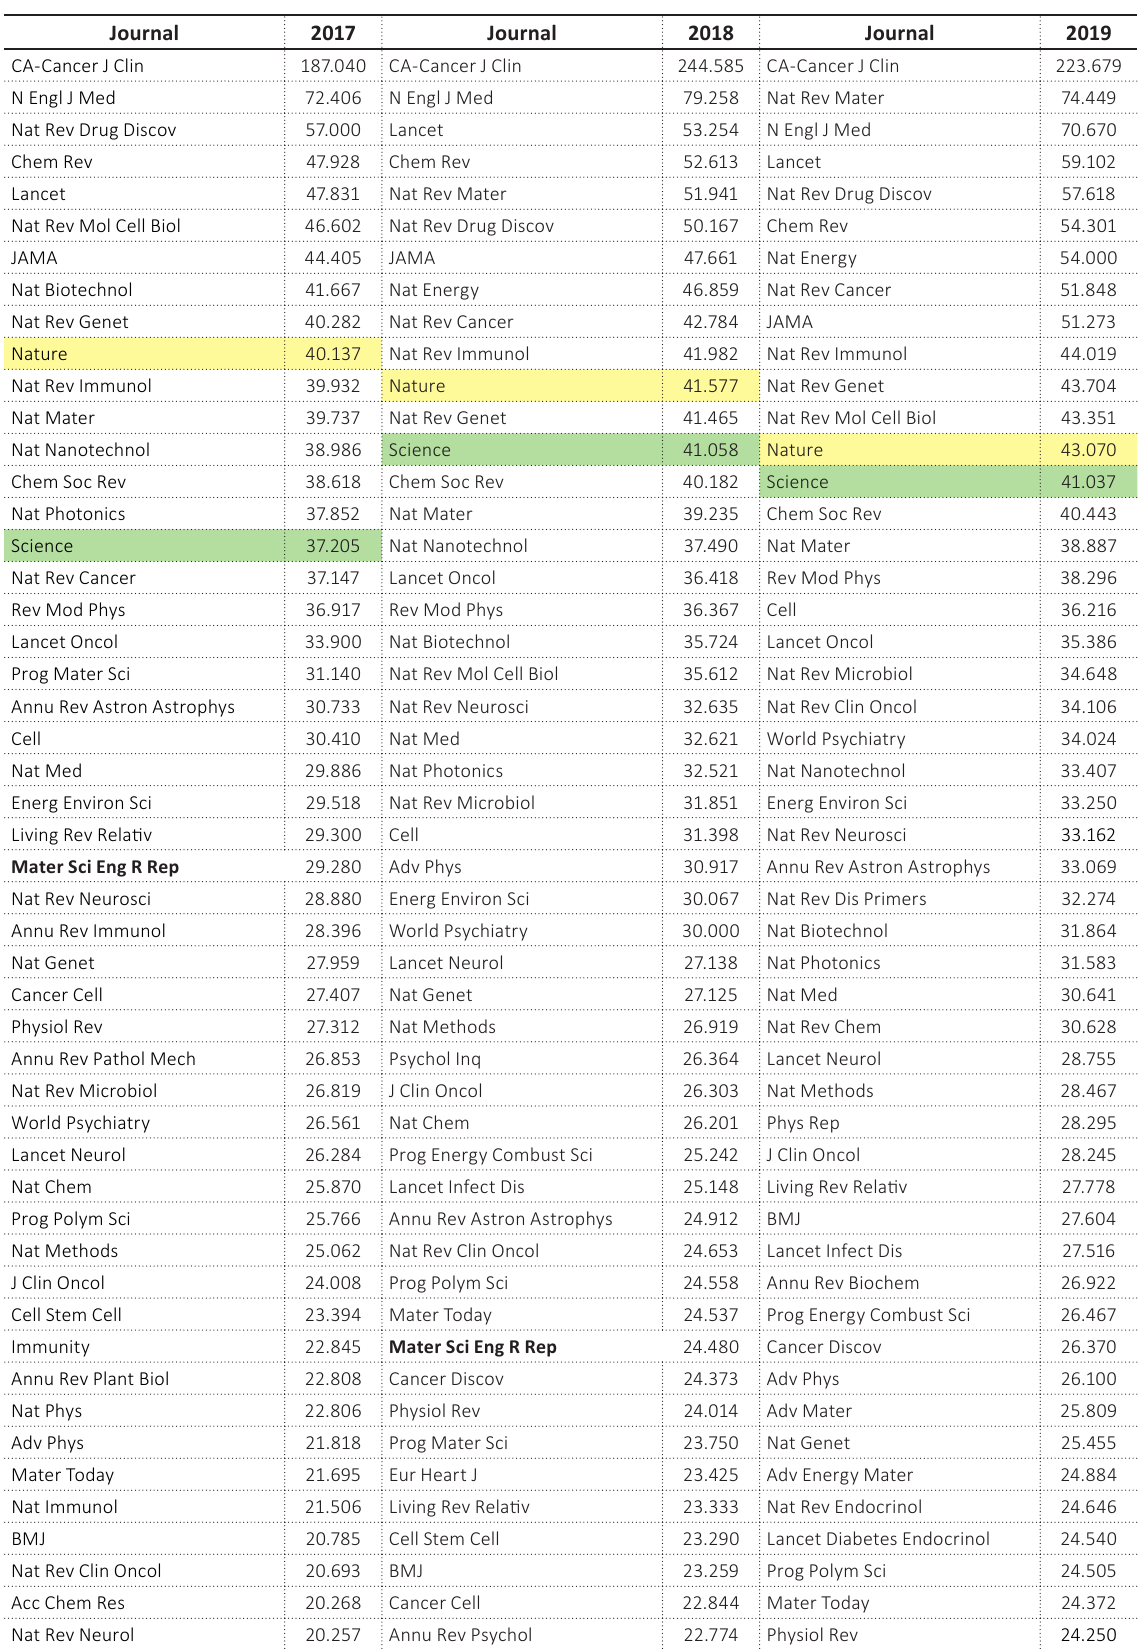
Table 1. Top 50 journals by JIF, JCR